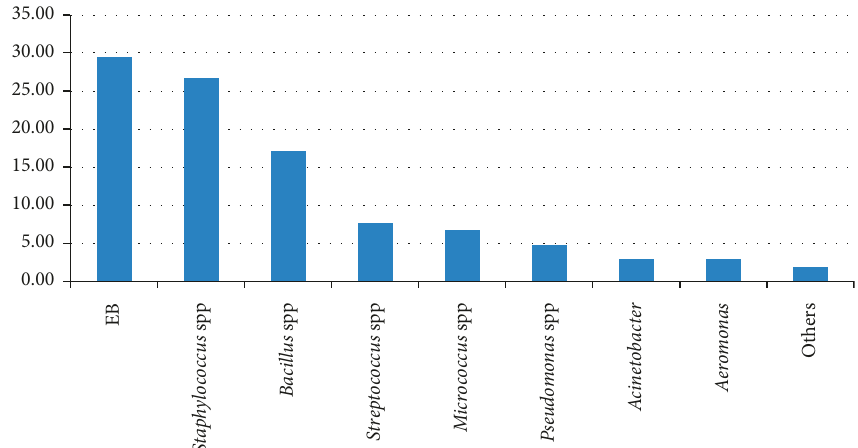
Figure 1: Frequency distribution of mesophilic bacteria in meats collected from and contact surface materials in butcher shops.